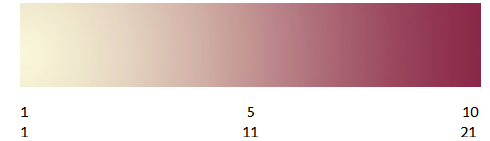
Figure 1. Typical scale used to compare colours using two scales: Schönbein (top line) and Berigny (botton